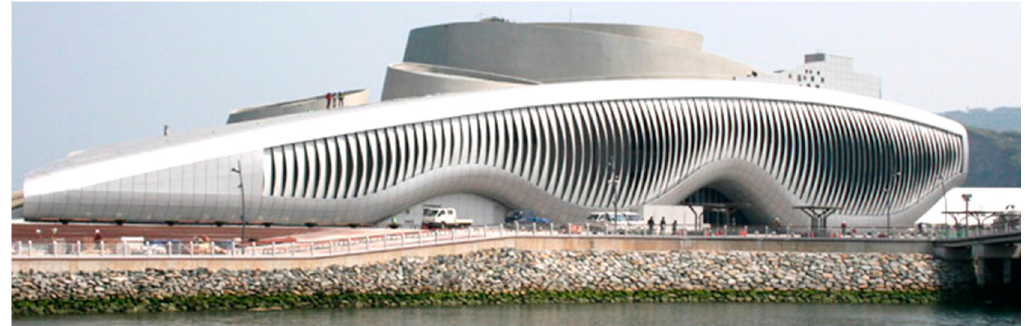
Figure 3. One Ocean Thematic Pavilion for Yeosu Expo 2012 South Korea designed by SOMA.